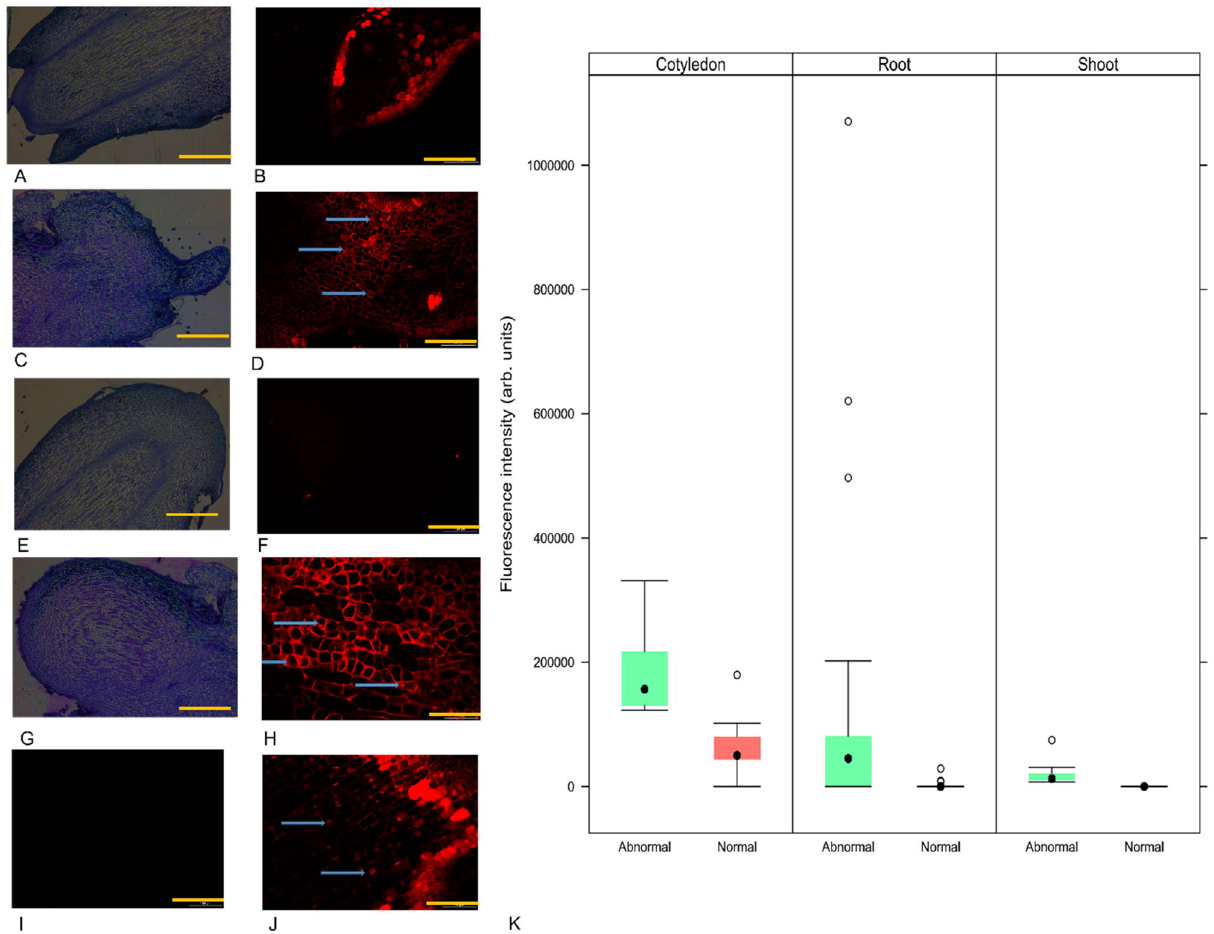
Figure 4. Histological and fluorescence micrographs of normal and abnormal somatic embryos. ( A ) Histological analysis of apical meristem of normal SE. ( B ) Cell death analysis in apical meristem of normal SE, where there is no presence of fluorescence stained in meristematic cells, but superficial cell layers in cotyledons show fluorescence. ( C ) Histological analysis of apical meristem of abnormal SE. ( D ) Cell death analysis in cotyledon and apical meristem of abnormal SE, the nucleus in meristematic and cotyledon’s regions are highly fluorescence stained. ( E ) Histological analysis of root meristem of normal SE. ( F ) Cell death analysis in root meristem of normal SE, where there are no cells-stained fluorescence. ( G ) Histological analysis of root meristem of abnormal SE. ( H ) Cell death analysis in root meristem of abnormal SE shows nucleus-stained red fluorescence. ( I ) Negative control of TUNEL reaction of NSE. ( J ) Positive control of TUNEL reaction of ASE. ( K ) Cell death detection through fluorescence analysis using the TUNEL reaction in normal and abnormal SE. Fluorescence intensity calculated in cells in normal and abnormal SE with cell death, where abnormal SE showed the high values in cotyledons and root meristem cells compared with normal SE. Scale bar, 400 µm (histological micrographs ( A,C,G,E )); 100 µm (fluorescence micrographs ( B,D,F,H,I )); 50 µm (Fluorescence micrograph ( J )). Arrows in blue color are showing apoptotic nuclei inside the cells-stained fluorescence. In figure ( K ) error bars are 95% confidence interval, and outliers are shown as transparent methylome are mainly sparsely methylated. The analysis regarding the functional regions differentially methyl- ated in the CHG context showed that introns and intergenic regions are the regions differentially methylated with the highest frequencies when compared to the DNA methylomes between ZE and normal SE (Fig. 5A), between ZE and abnormal SE (Fig. 5B) and between normal and abnormal SE (Fig. 5C). Interestingly, the CHH context has the same profile as the CHG context in the DNA methylome of the ZE, normal and abnormal SE. In the CHH context the samples were grouped in the hierarchical clustering similarly as in the CHG context, normal and abnormal SE are together in the same cluster and ZE is grouped in a different cluster than SE. Dif- ferentially methylated regions have the lowest levels of methylation in this context, with values between 0.0 and 0.1, and the high frequencies of functional regions differentially methylated between samples are also the introns and intergenic regions (Supplementary Fig. S9A–G). The dynamics in the CpG context are different compared to the CHG and CHH contexts. The methylated CpG region coverage per base followed a normal distribution for ZE, normal and abnormal SE with high fre- quencies of values between 1 and 2 log 10 of read coverage per base and with percentages between 30.4 and 37.3 of coverage (Fig. 6A). The percentage of methylation in all CpG regions presented a bimodal distribution for